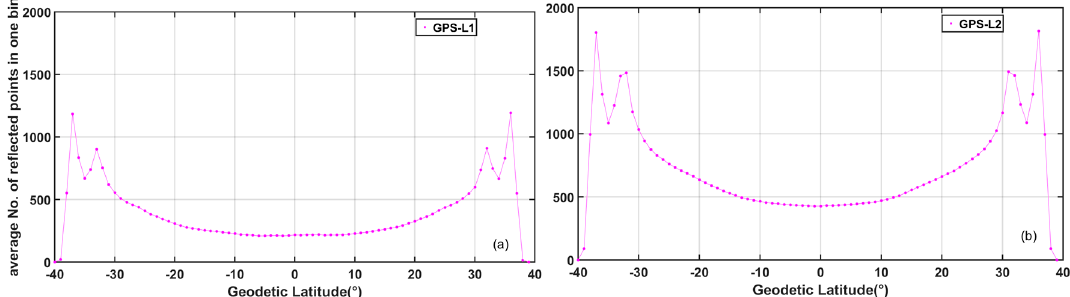
Figure 9. Average numbers of GPS-R specular reflection points in 1° × 1° grids at different latitudes during a complete 13-day cycle at the GPS L1 ( a ) and L2 ( b ) frequencies.